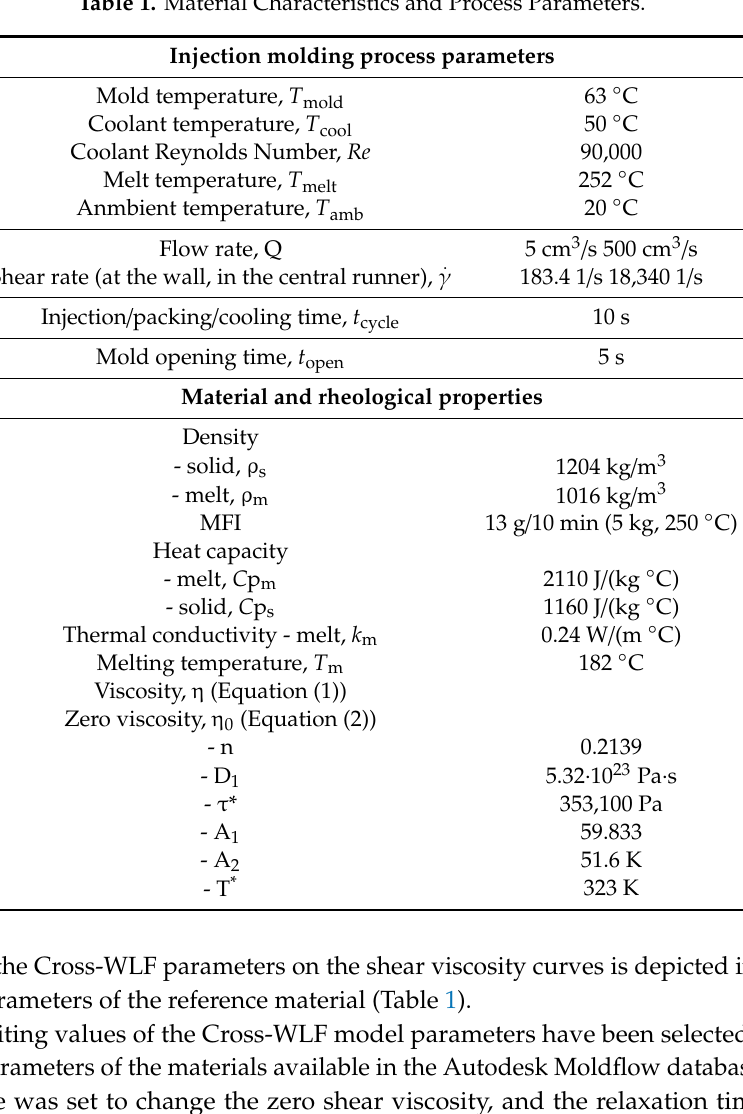
Table 1. Material Characteristics and Process Parameters.